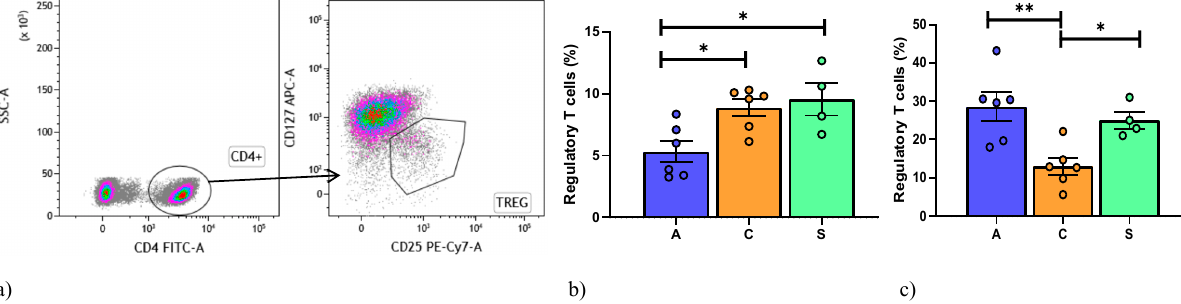
Figure 2. ( a ) Gating strategy used to analyze markers for Regulatory T cells detection. Treg are CD127 − CD25. ( b ) Data represent individual values on PBMC, mean (center bar) ± SEM (upper and lower bars). If not indicated, p value is not significant. * p < 0.05, ** p < 0.01. ( c ) Data represent individual values on BAL samples, mean (center bar) ± SEM (upper and lower bars). Statistical analysis by Mann–Whitney nonparametric test; if not indicated, p value is not significant. * p < 0.05, ** p < 0.01. Abbreviations: A: acute, C: chronic, S: